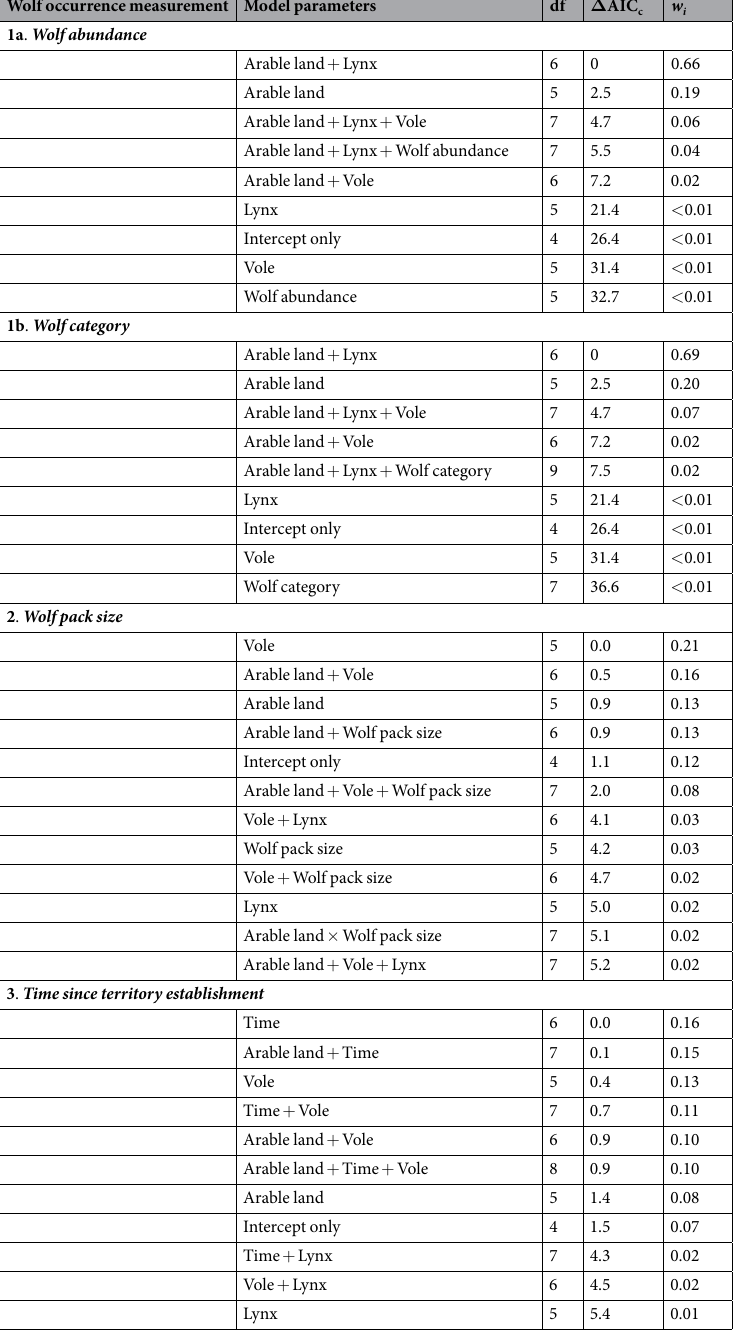
Table 1. Highest ranked candidate models relating red fox abundance (crossings 10 km − 1 24 h − 1 ) to arable